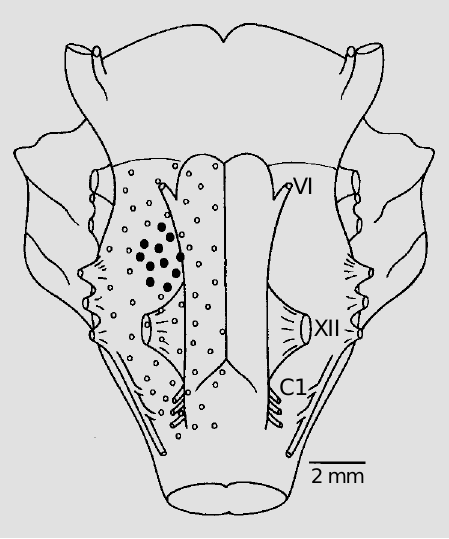
Table 1 - Cardiorespiratory responses produced by unilateral microinjections of kynurenic acid into the ventrolateral